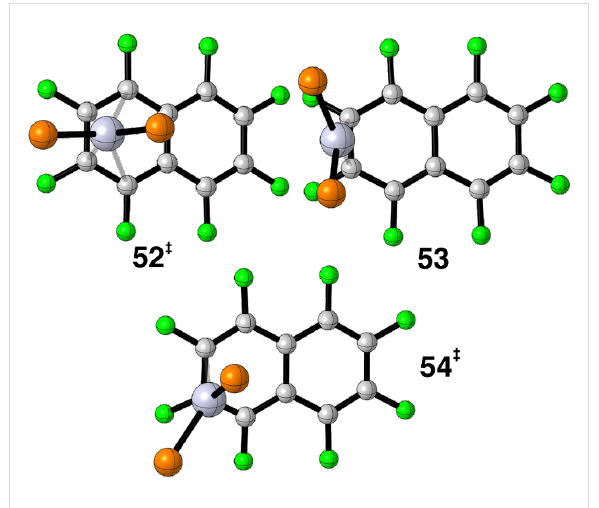
Figure 15: At top view of the η 4 , 52 , and η 4 , 54 , transition states along with the η 2 , 53 , intermediate.